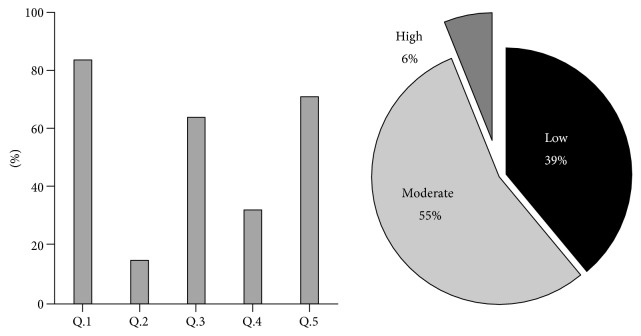
Results of individuals' knowledge of diabetes and diabetes nutritional knowledge by the validated “Theptarin DM questionnaire” (N = 213 cases).